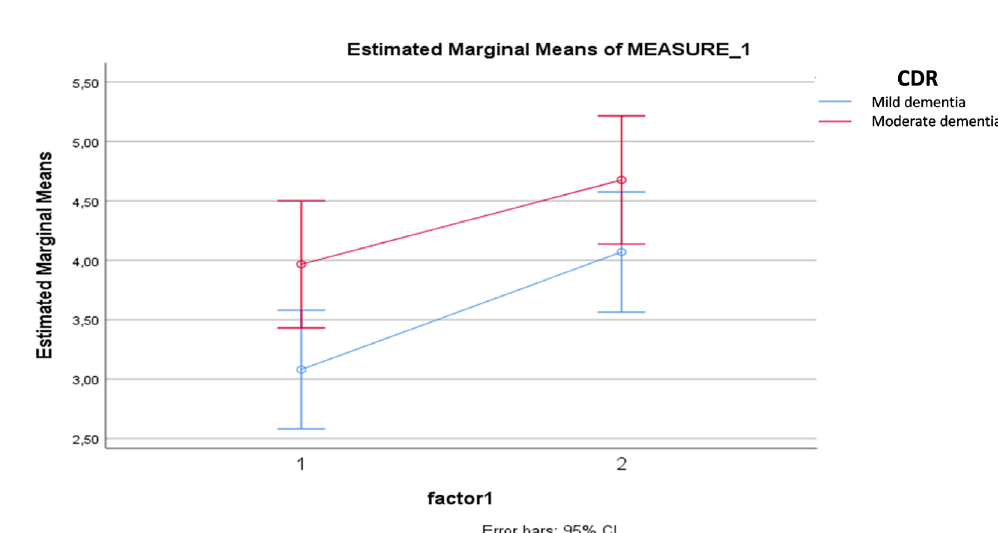
Figure 2. Difference in the neuroticism factor scores between the groups.